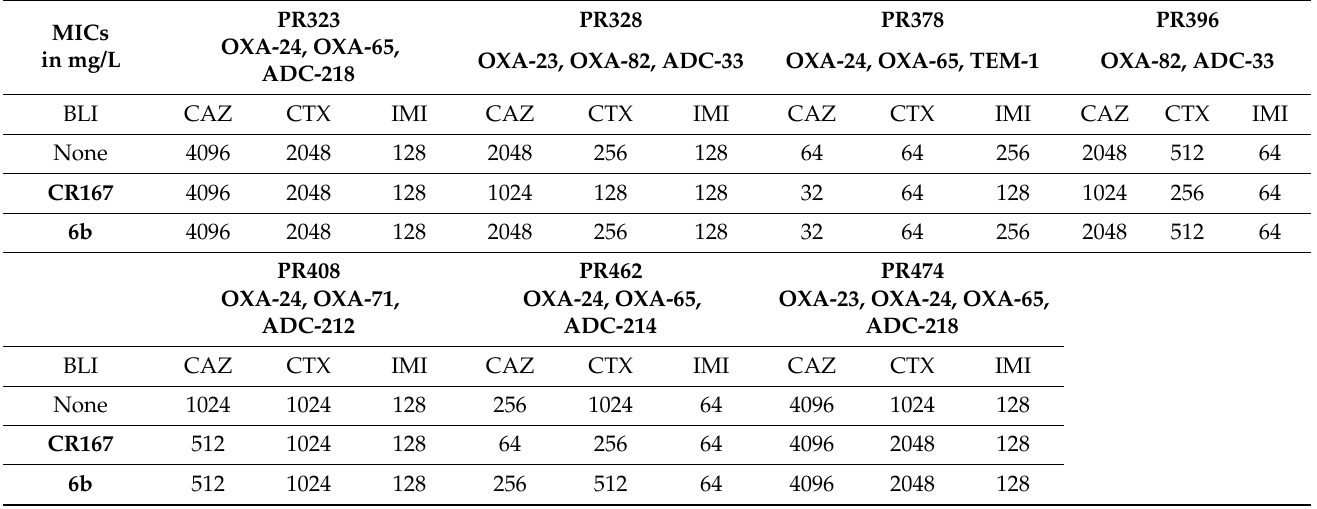
Table 5. Antimicrobial susceptibility testing results for clinical A. baumannii isolates containing ADC- 33 and OXA-24/-40 using broth microdilution. The inhibitors CR167 and 6b were used at 10